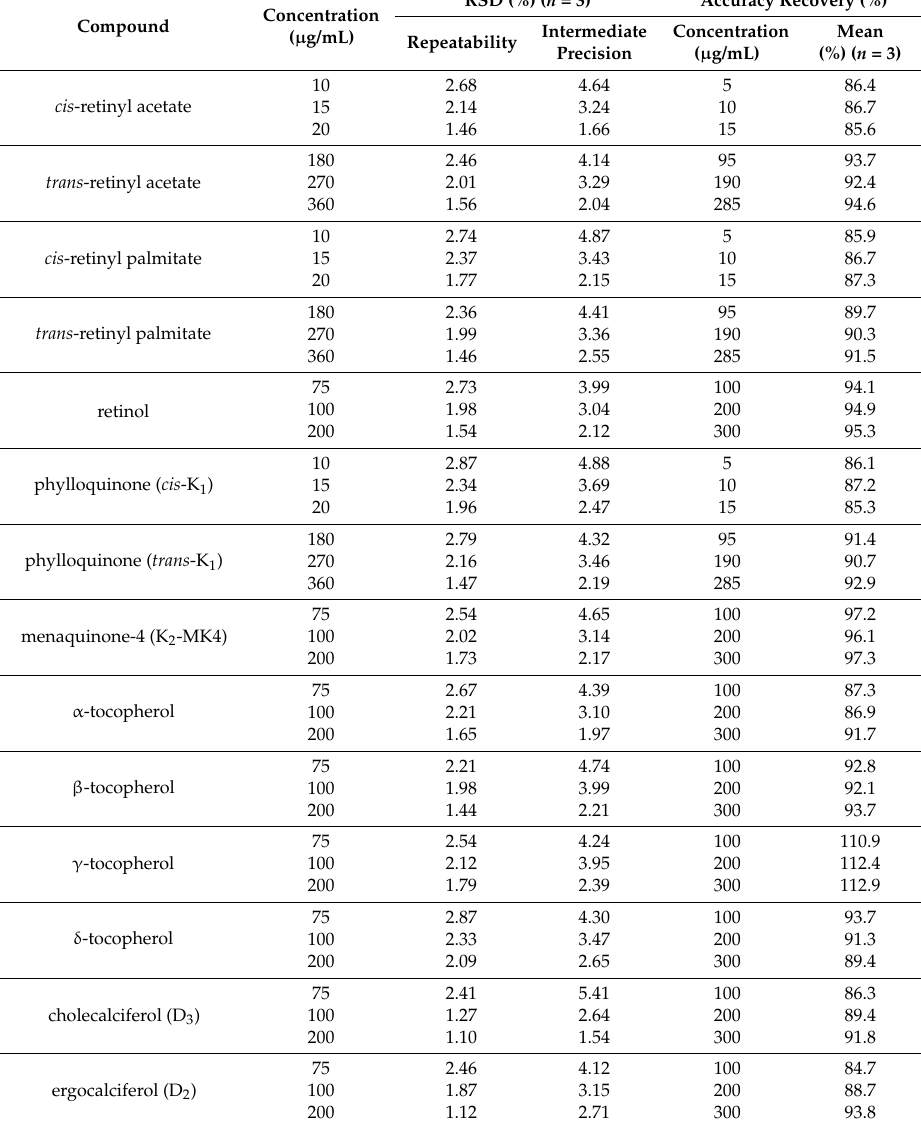
Table 3. Repeatability and intermediate precision for analyzing fat-soluble vitamins using the UPC 2